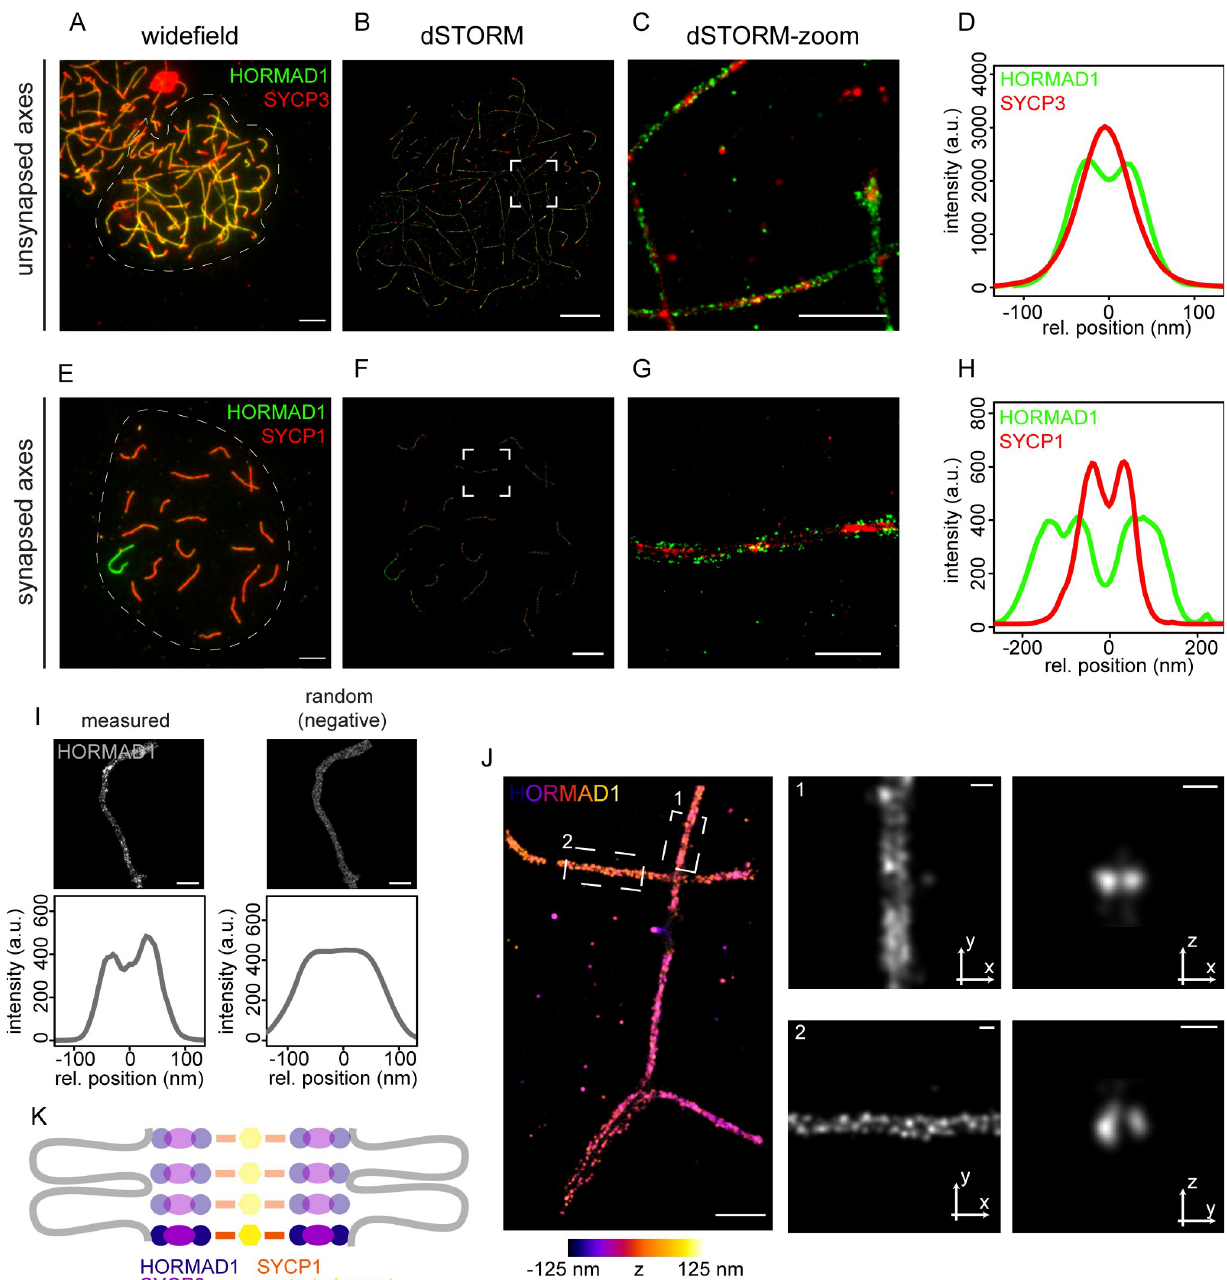
Fig 1. Two-color dSTORM images of nuclear surface spread spermatocytes immunostained for synaptonemal complex proteins on synapsed and unsynapsed chromosomal axes. A) Widefield image of a mouse zygotene nucleus immunostained for HORMAD1 (green) and SYCP3 (red). The indicated region (dashed line) is visualized with dSTORM in B). C) Close-up of boxed region shown in B. D) Average intensity-profiles of HORMAD1 (green) and SYCP3 (red) at unsynapsed chromosomal axes (from 3 zygotene cells, 8 chromosome regions). E) Widefield image of a mouse early pachytene nucleus immunostained for HORMAD1 (green) and SYCP1 (red). The indicated region (dashed line) is visualized with dSTORM in F). G) Close-up of boxed region shown in F. H) Average intensity-profiles of HORMAD1 (green) and SYCP1 (red) at synapsed chromosomal axes (from 2 early pachytene cells, 8 chromosome regions). I) Random control for two axes of HORMAD1. Localizations from the measured data were randomly positioned in the same area whereafter the intensity profiles were measured. J) 3D-dSTORM of HORMAD1 in zygotene nucleus. The z-position is specified with the colored scale bar. The panels on the right represent the area 1 (top panels) and 2 (lower panels) indicated on the left. For each area, the signal in the XY plane (middle) and the XZ/YZ plane (right) is enlarged. The two indicated stretches show a representative frontal view and a single slice of the axial view. K) Cartoon of HORMAD1 position in the SC. Other components of the SC are depicted in different colors. The chromatin is schematically depicted in grey. Scale bars represent 5 μ m (A,B,E,F), 500 nm (C,G,J—left panel) and 100 nm (I and J—middle and right panels). All separate intensity profiles used to generate D and H are shown in S1 and S2